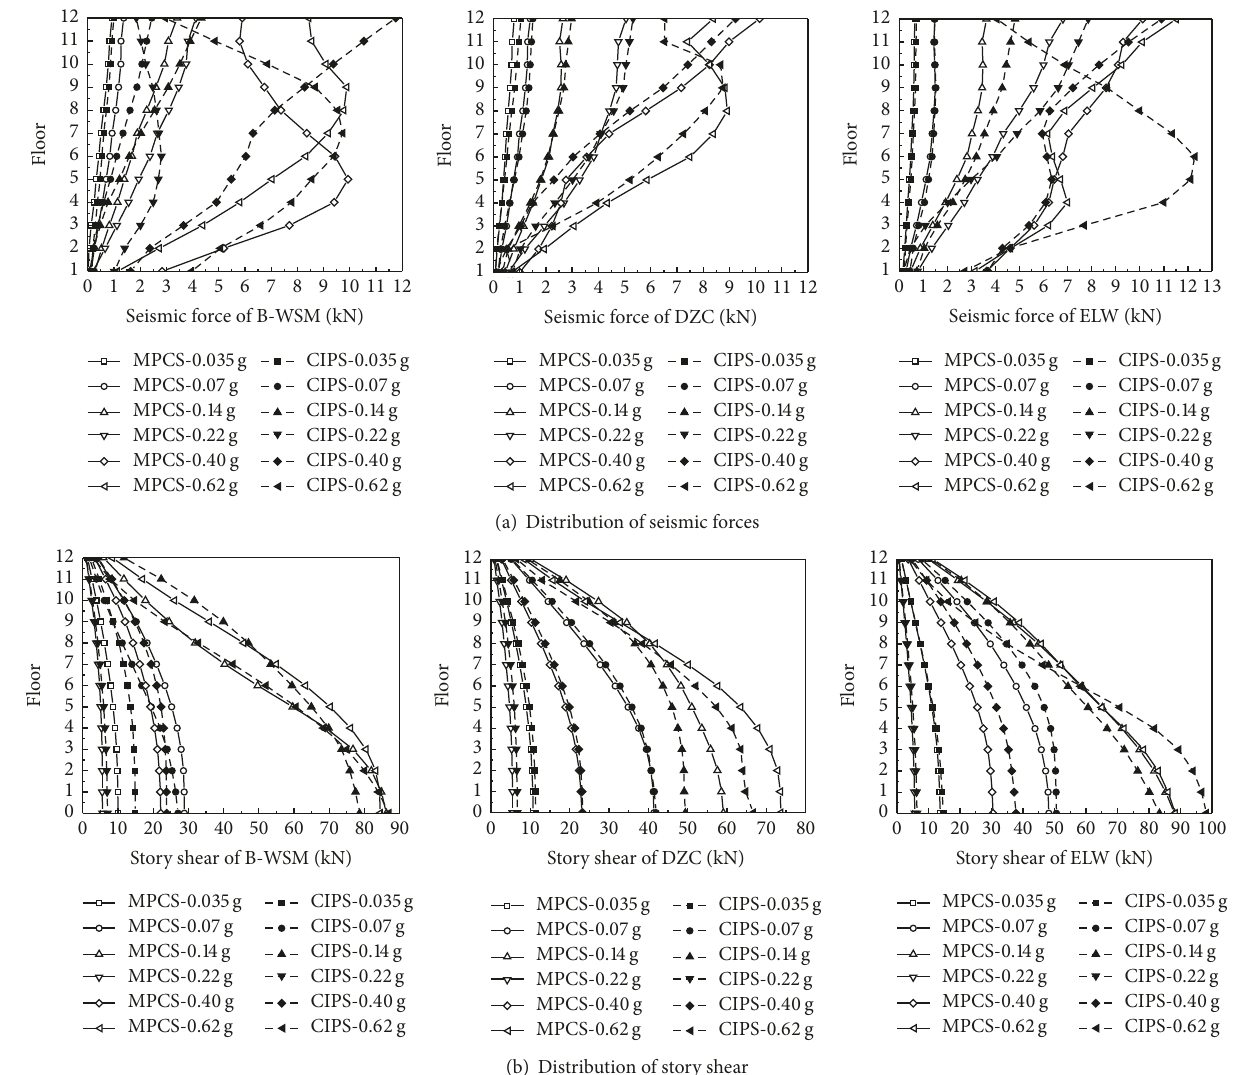
Figure 11: Earthquake actions of CIPS and